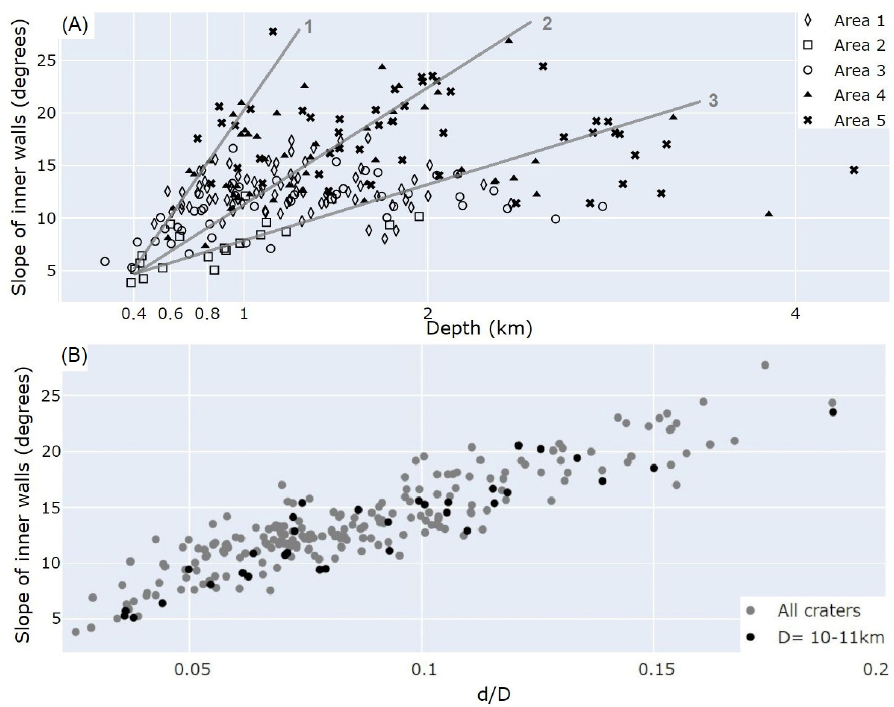
Figure 12. ( A ): slope of inner walls (Sw) versus depth. Lines indicate three different apparent data trends (All craters plotted). ( B ): Sw vs d/D ratios for all craters (gray) and for craters with diameter between 10 and 11 km (black).